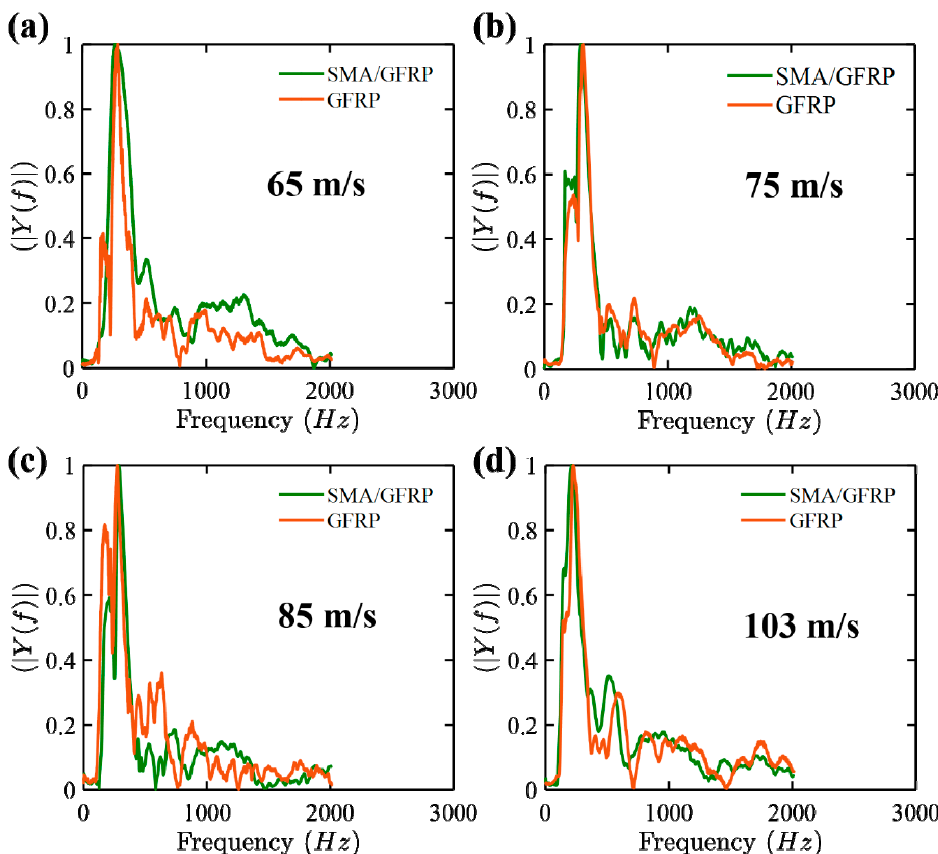
Figure 9. Frequency response for the GFRP and SMA/GFRP specimens at different impact velocities ( a ) 65 m/s, ( b ) 75 m/s, ( c ) 85 m/s, and ( d ) 103 m/s.